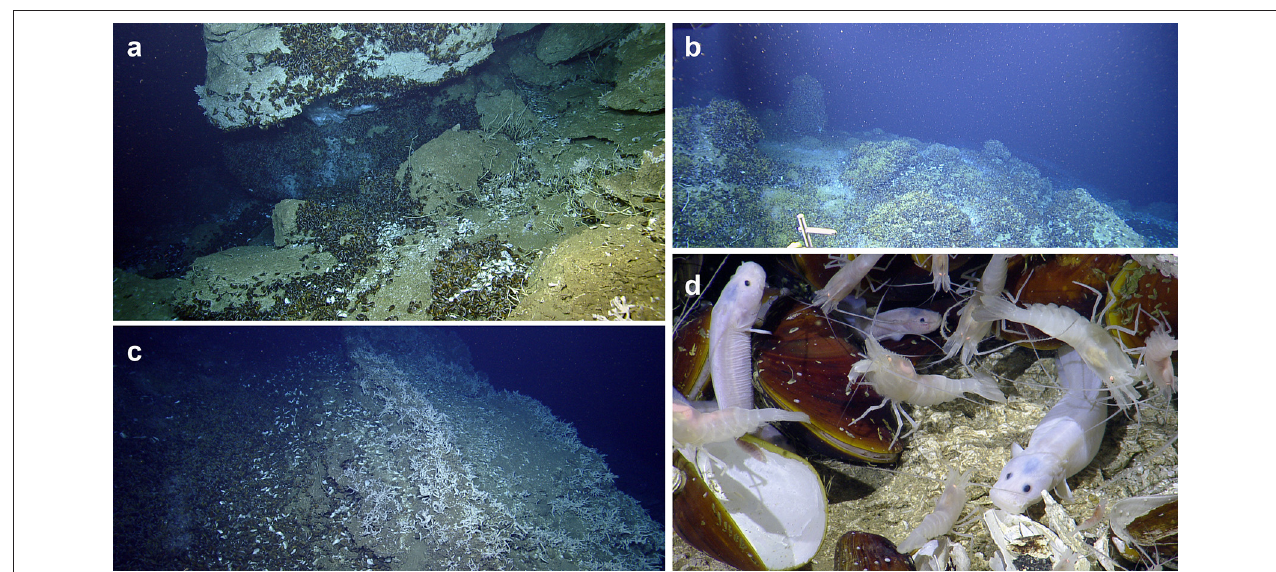
FIGURE 2 | Methane-seep sites at El Pilar off Trinidad and Tobago. (a) The methane seep on “Dome 2” containing methane hydrate under an authigenic carbonate ledge surrounded by Bathymodiolus childressi , Lamellibrachia sp. 2 and other fauna. (b) Pinnacle structures covered in high abundances of B. childressi and other fauna at a methane seep on “Dome 1.” (c) Chemosynthetic communities in depressions at “Mama D’Leau,” dominated by B. childressi , are surrounded by authigenic carbonates hosting Haplosclerida n. sp. and Lamellibrachia sp. 2. (d) B. childressi , Alvinocaris cf. muricola, Pachycara caribbaeum, and Gastropoda sp. 1 at a methane seep at “La